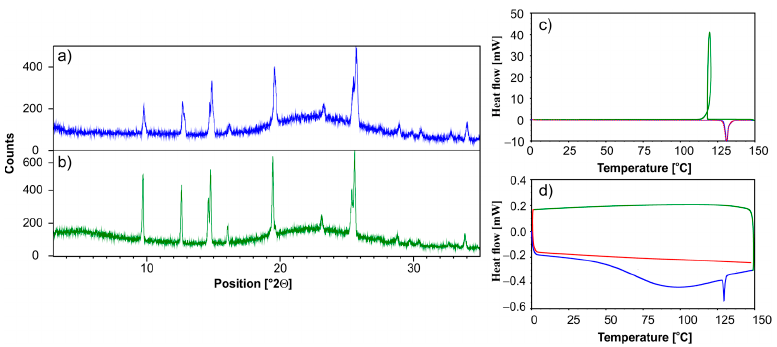
Figure 5. PXRD of ( a ) physical mixture ET/SiO 2(calc) , ( b ) physical mixture ET/SiO 2(hydr) recorded on a PANalytical 3 kW system in Bragg–Brentano geometry and with a Cu K α ( λ = 1.5425 Å) source. The DSC measurements of ( c ) ET and ( d ) physical mixture ET/SiO 2(hydr) . The fi rst heating run from 0 °C to 150 °C (blue line), then a cooling run from 150 °C to 0 °C (green line), followed by a second heating run from 0 °C to 150 °C (red line).